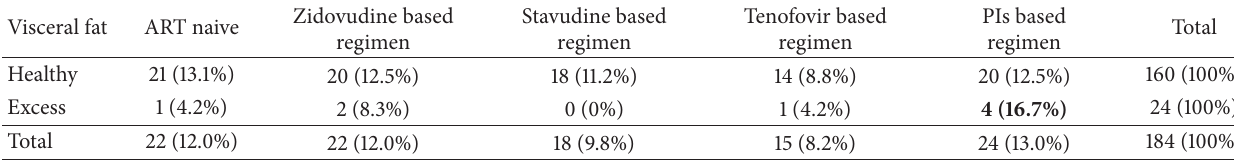
Table 3: Prevalence of excess and healthy visceral fat among study population.